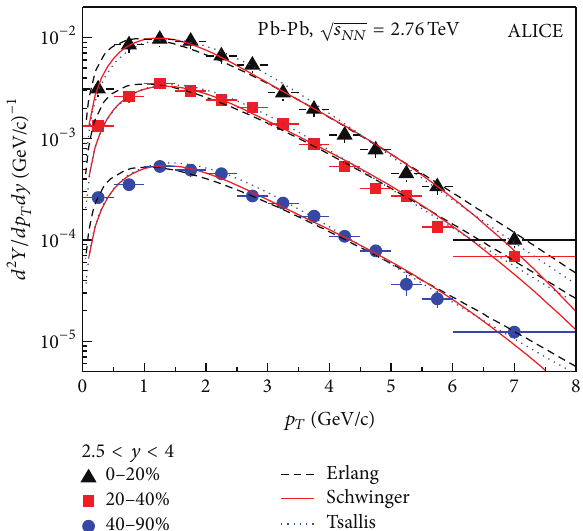
Figure 5: Transverse momentum spectra of 𝐽/𝜓 produced in three centrality classes in Pb-Pb collisions at √𝑠 𝑁𝑁 = 2.76 TeV. The sym- bols represent the experimental data of the ALICE Collaboration [20]. The dashed, solid, and dotted curves are our results calcu- lated by using the two-component Erlang distribution, the two- component Schwinger mechanism, and the Tsallis statistics, respec-